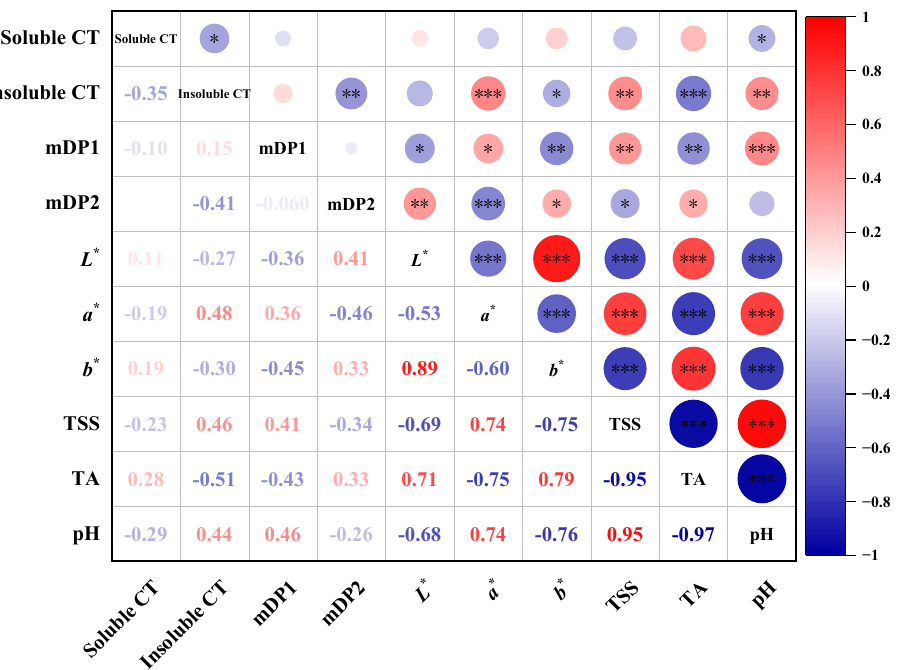
Figure 8. Correlation of seed tannin content with seed coat color index and berry ripening index. mDP1 and mDP2 represent the mean polymerization degree of soluble and insoluble CT, respectively. TSS represents the total soluble solid and TA is the titratable acidity. L * represents the lightness indicator ( L * = 0 for black, L * = 100 for white). a * and b * are two color indicators ( a * > 0 for red, a * < 0 for green; b * > 0 for yellow, b * < 0 for blue). *** represents a significant correlation at p < 0.001, ** represents a significant correlation at p < 0.01, and * represent a significant correlations at p <